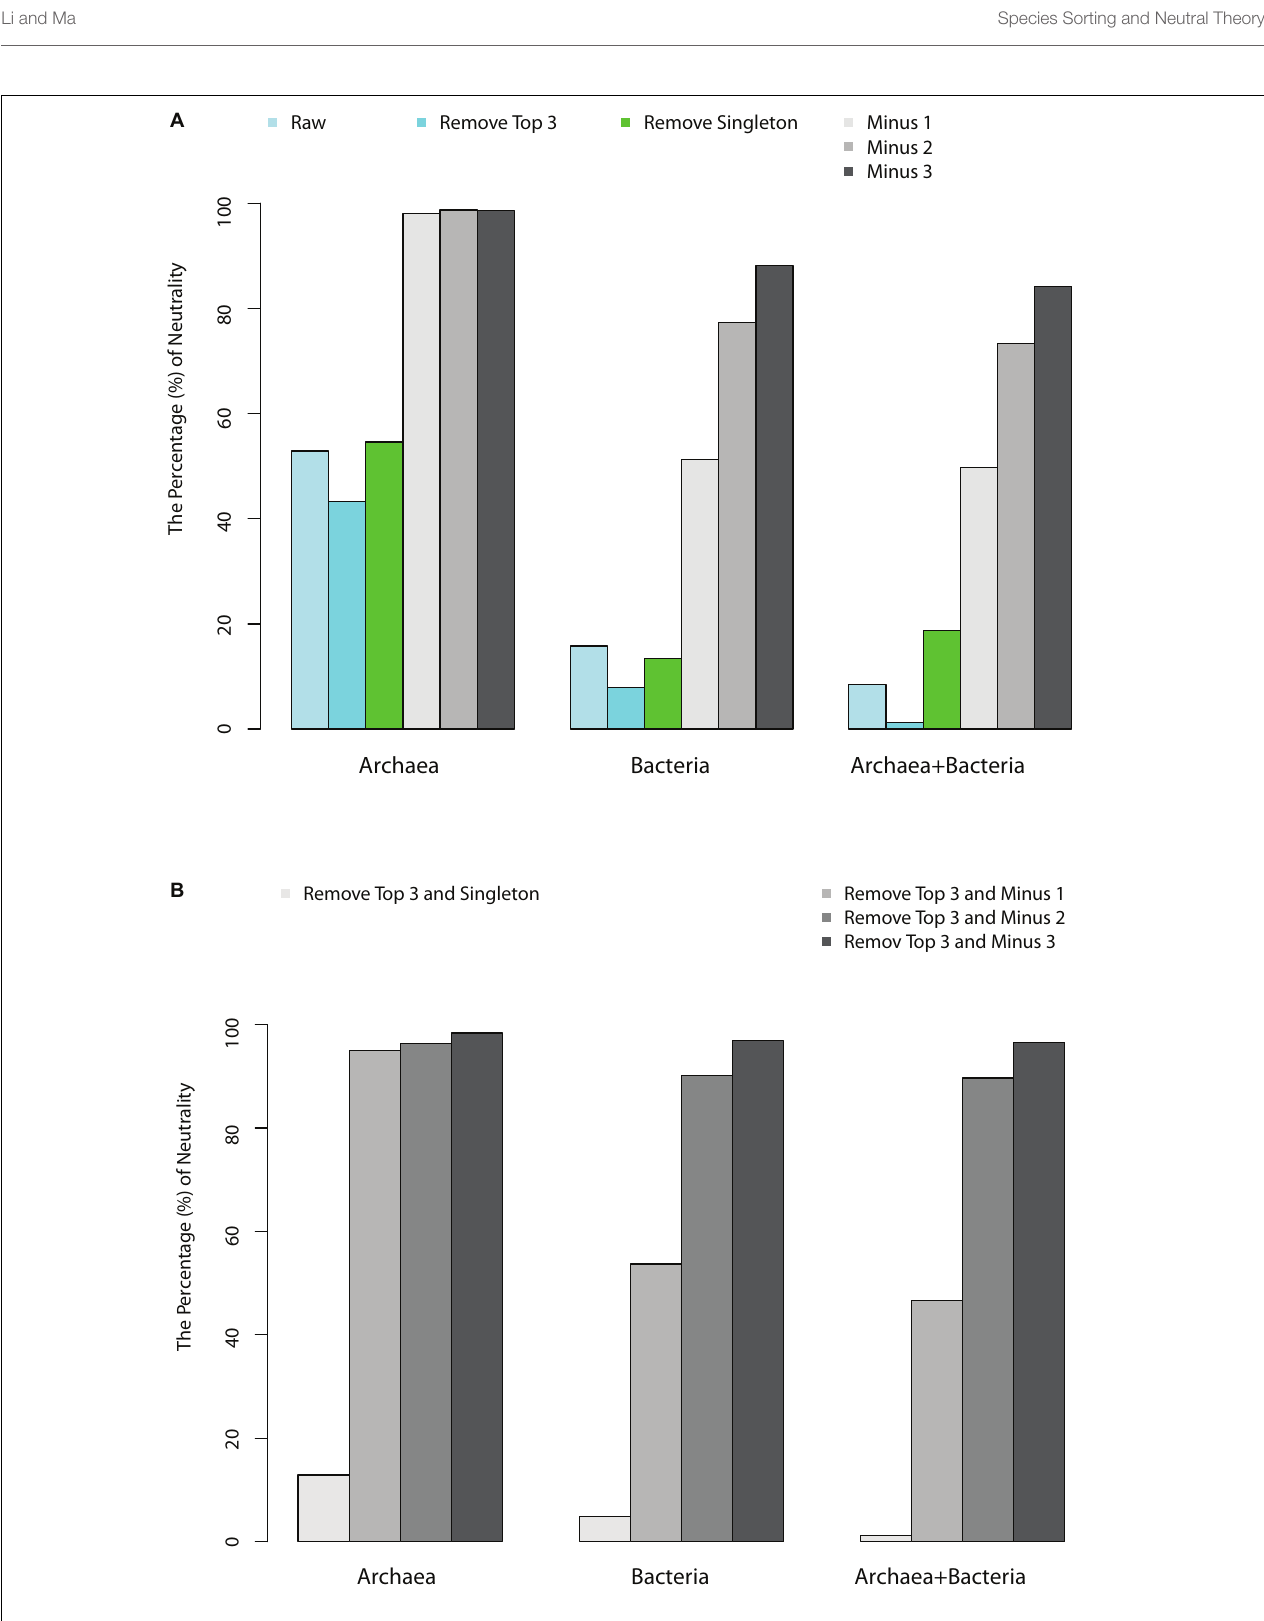
FIGURE 1 | (A) Percentages of hot-spring microbiome samples that passed the neutrality test with the schemes of “remove top 3,” “remove singleton,” “minus 1,” “minus 2,” and “minus 3.” (B) Percentage of samples that passed the neutrality test with “remove top 3 and singleton,” “remove top 3 and minus 1,” “remove top3 and minus 2,” “remove top 3 and minus